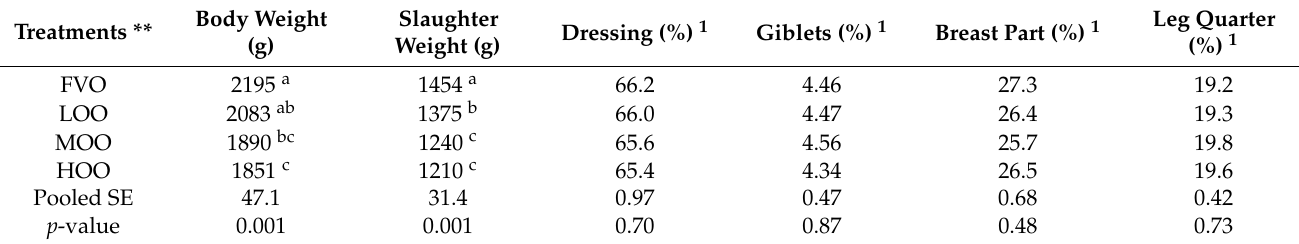
Table 2. Influence of different dietary oxidation levels of vegetable oil on carcass characteristics in broilers *. Treatments